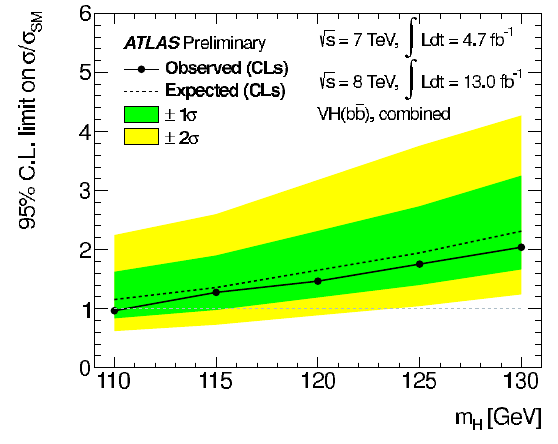
Figure 4. Expected (dashed) and observed (solid) CL s limit on the normalised signal strength as a function of m H for all chan- nels [9].